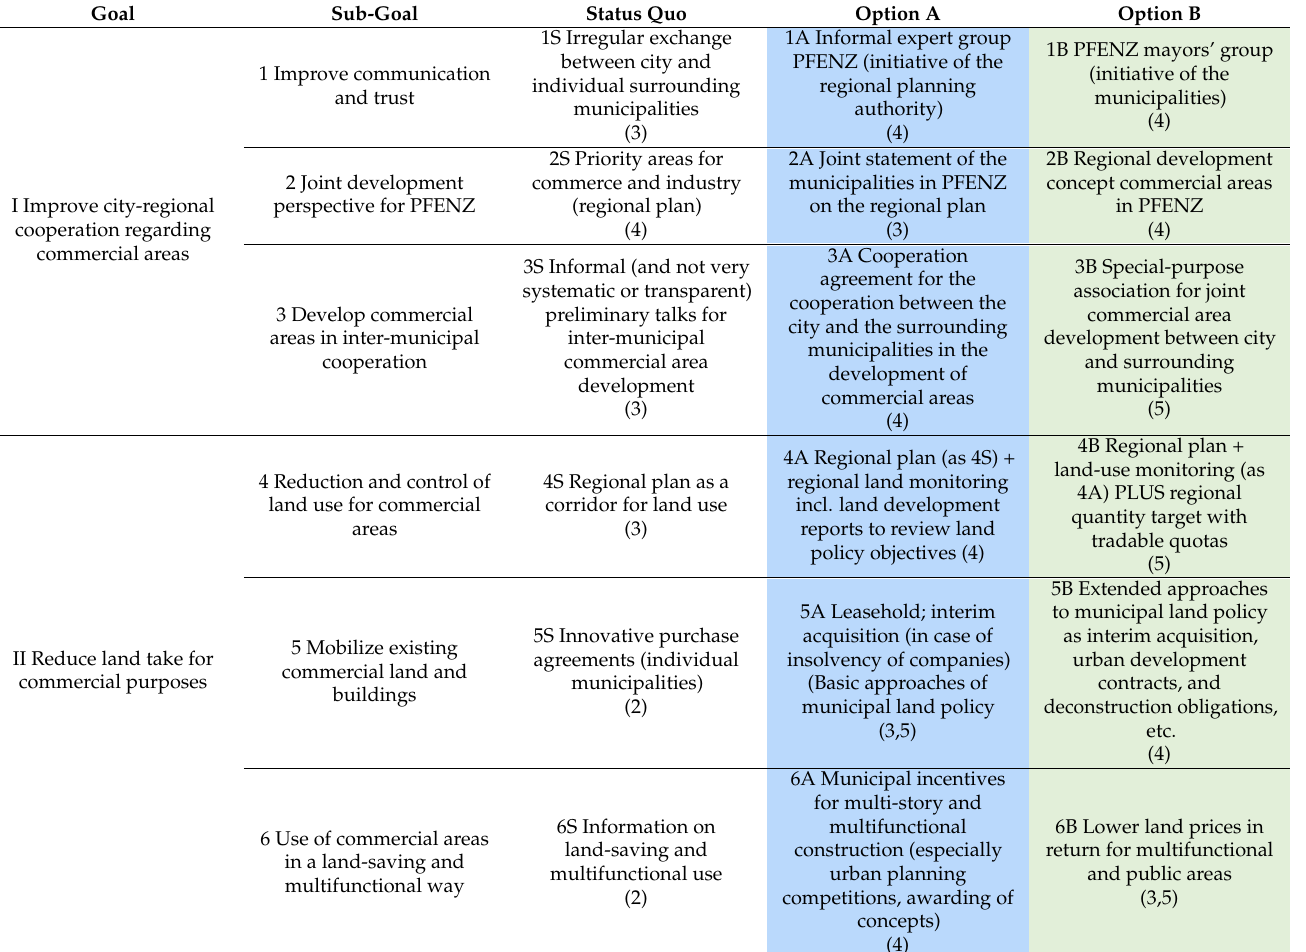
Table 1. Overview of sub-goals and policies and their initial effectiveness (PFENZ). Status quo policies: target not (fully) achieved. Numerical value in brackets: effectiveness of individual policy with regard to the respective sub-goal. Based on a preliminary survey among the respective 4–5 topic experts, joint validation during workshop 2. Scale: (1) = not effective, (2) = less effective, (3) = rather effective, (4) = effective, (5) = very